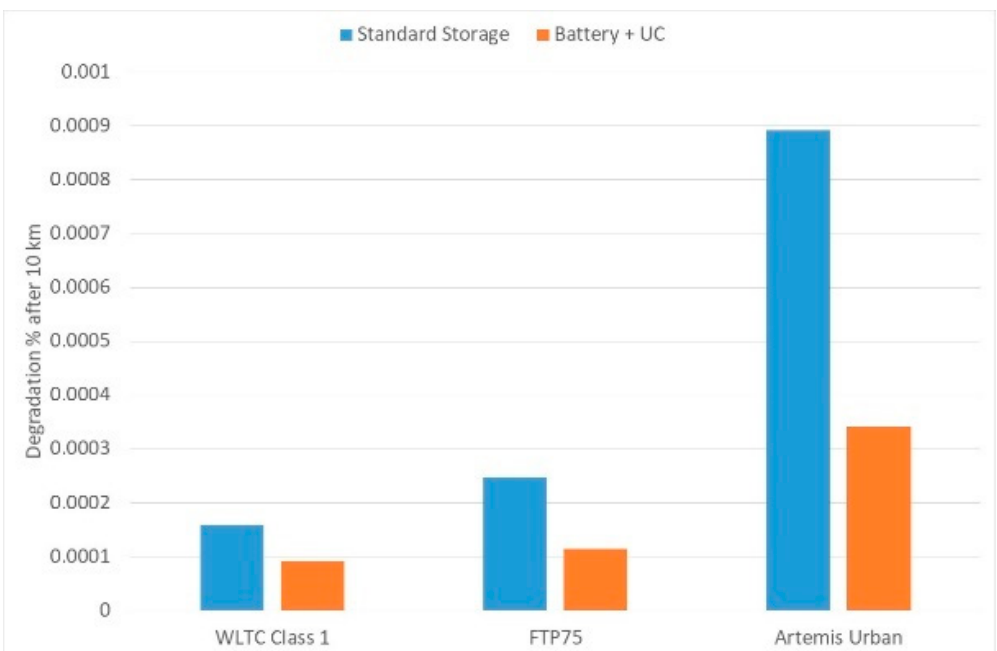
Figure 17. Increased life% with varying the mission distance for different driving cycles.